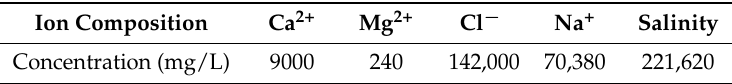
Table 1. Chemical analysis of the brine.